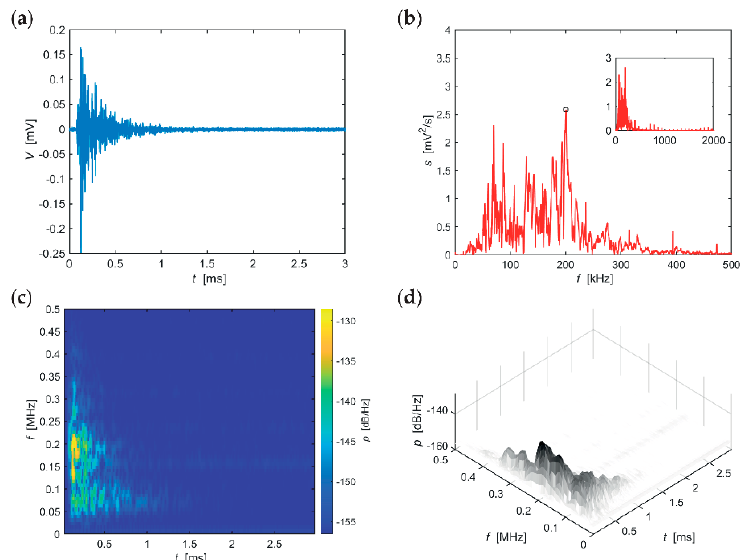
Figure 5. Visualisation of the recorded AE signal during 0–25 F-T cycles from specimens CS100: ( a ) time course of the amplitude, ( b ) frequency spectrum, ( c ) spectrogram STFT-2D image, ( d ) spec- trogram STFT-3D image.